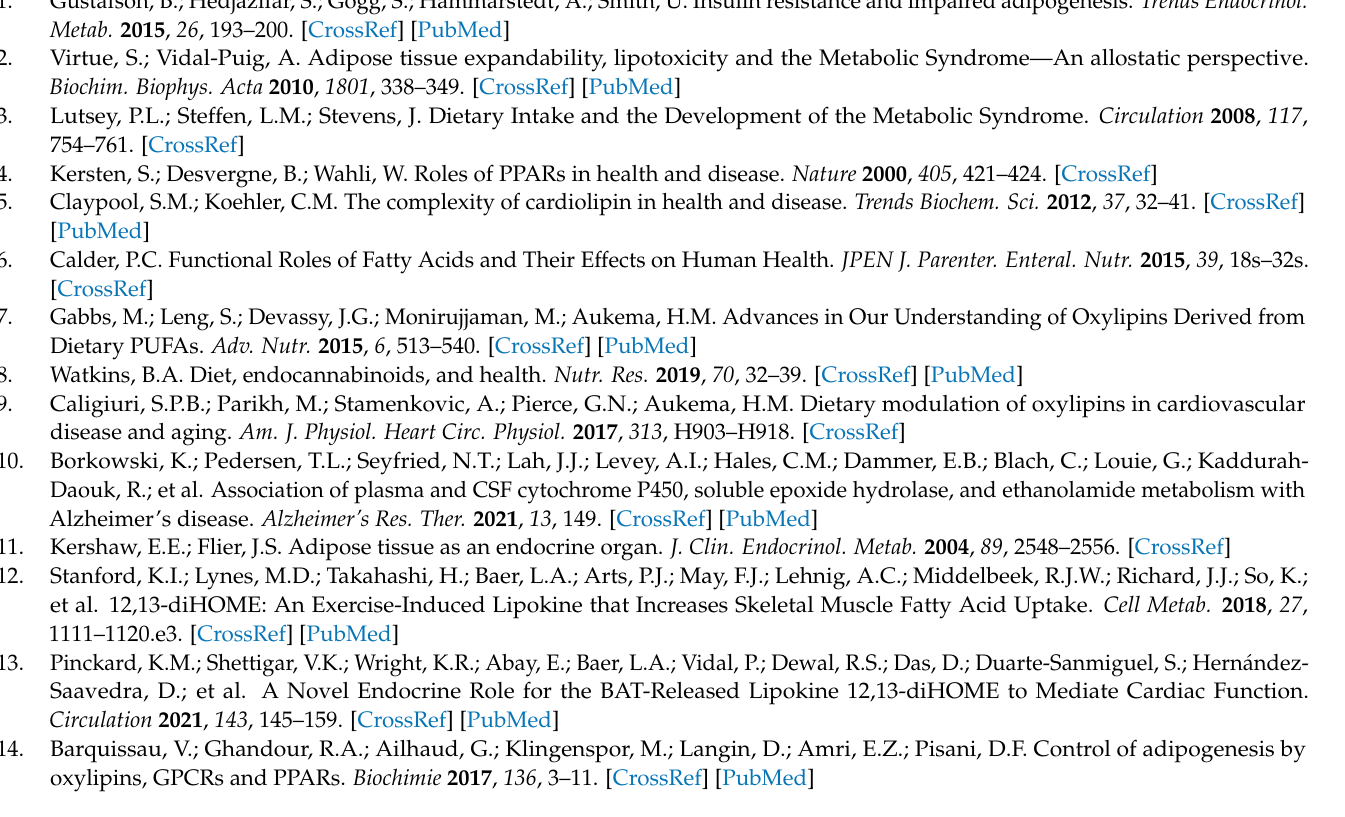
diets; Table S3: Spearman’s rank order correlation coefficients for diet-independent changes to lipid mediators and physiological measurements; Table S4: Percent of total fold difference by enzymatic pathway in BAT, WAT, and plasma; Table S5: average fold difference within each enzymatic pathway in BAT, WAT, and